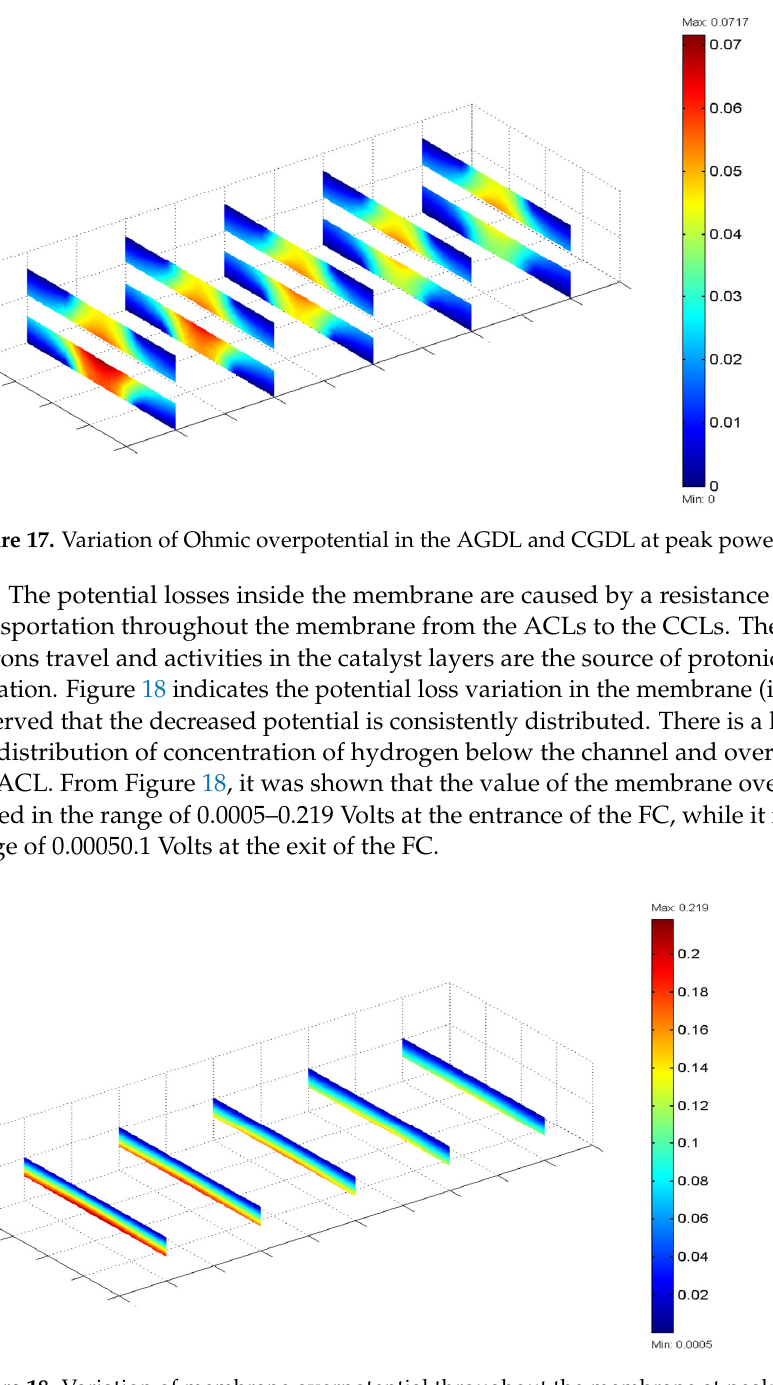
where the variation shows a decrease in both x- and y-directions as a result of the non- uniform regional current creation.